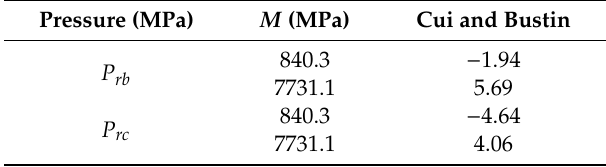
Table 7. The rebound pressure P rb and recovery pressure P rc values for the Cui and Bustin model, as obtained for the coal from the Mannville Group basin, Lower Cretaceous, Western Canada.